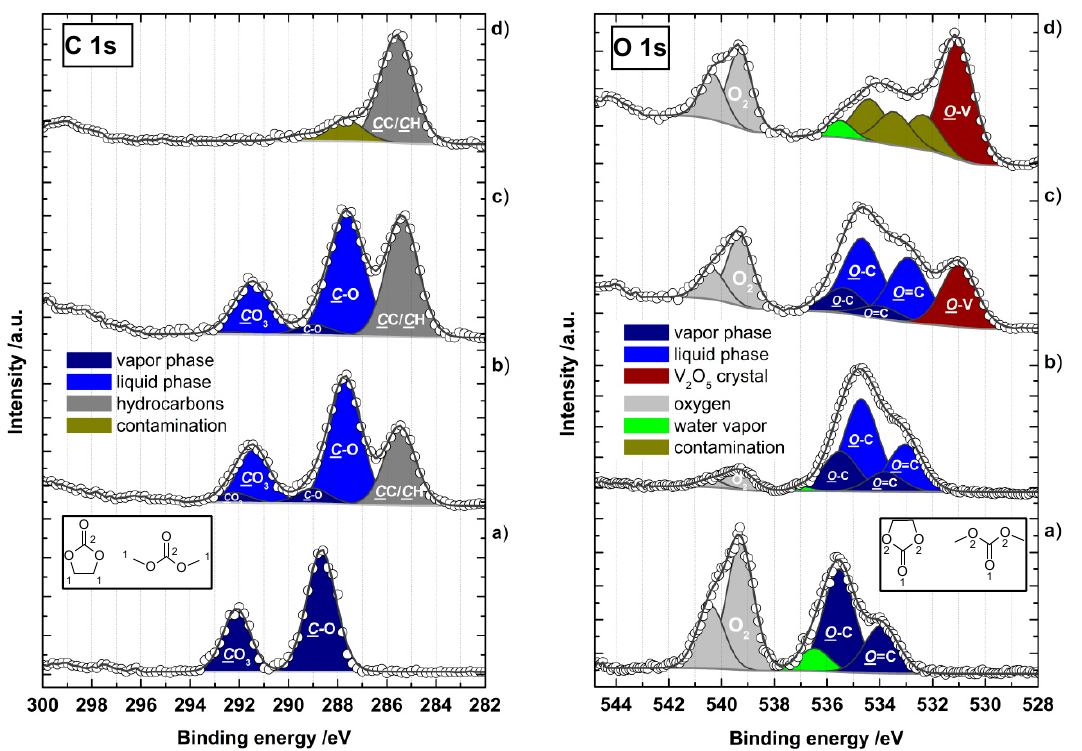
Figure 2. C 1s ( left panel ) and O 1s ( right panel ) core-level spectra of the LiPF 6 electrolyte in EC / DMC: ( a ) gas phase; ( b ) liquid phase with surrounding gas; ( c ) in contact with V 2 O 5 ; and ( d ) the same crystal after cleaning with EtOH. Open circles represent experimental data and black lines are envelopes of fitted curves.